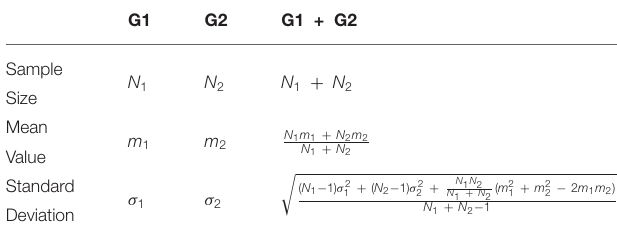
TABLE 2 | Formulas for merging data of two